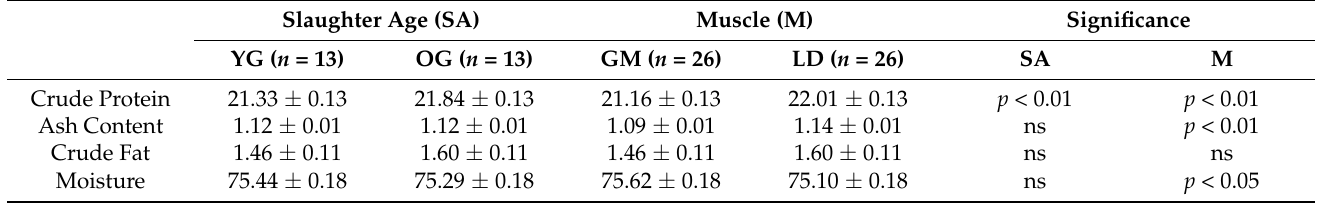
Table 1. Chemical composition of the GM and LD muscles of bulls slaughtered at different ages expressed as least squares means ± standard errors.